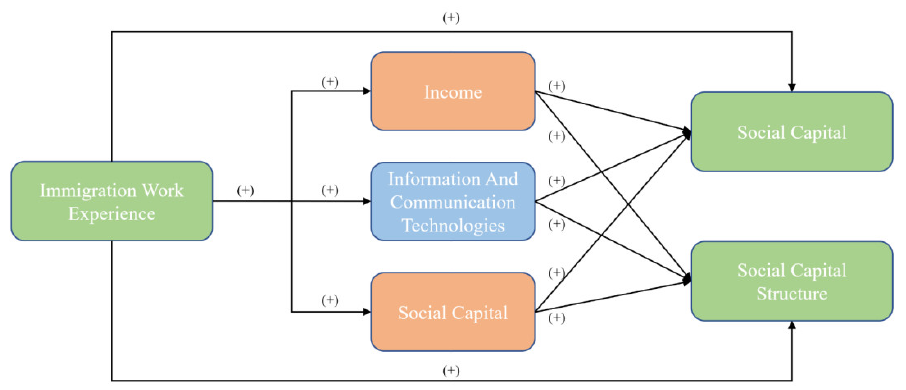
Figure 3. Influence Mechanism of MWE on Social Capital Structure.